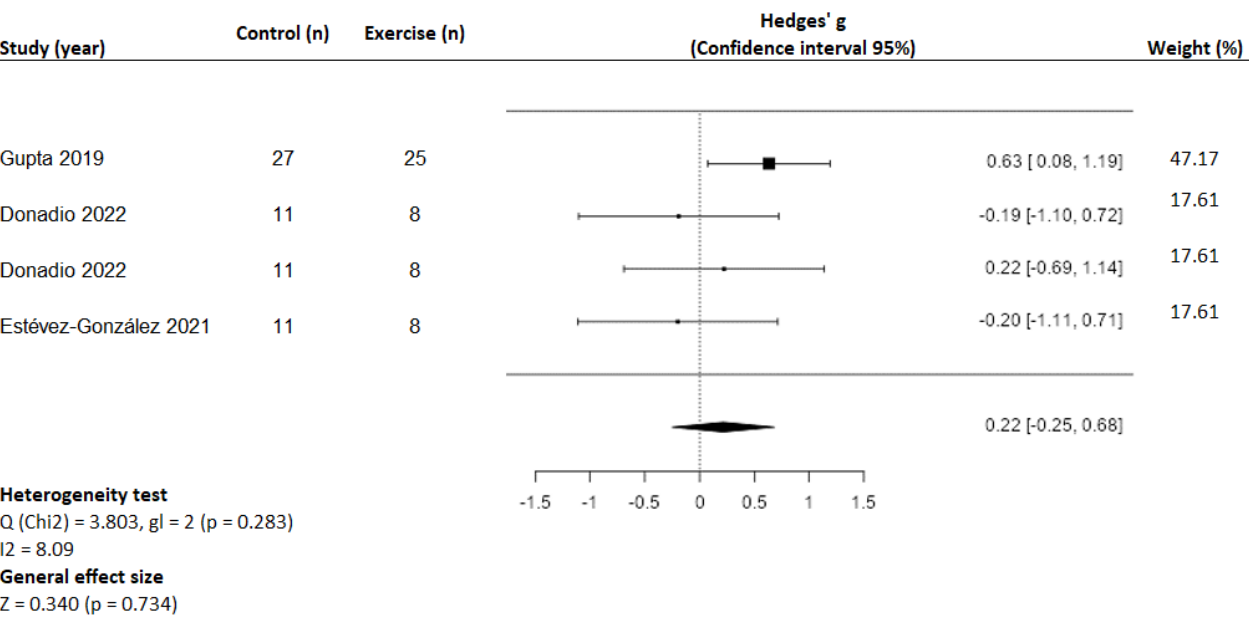
Figure 4. Meta-analysis and forest plot of VO2 peak in children with cystic fibrosis [26,27,30].